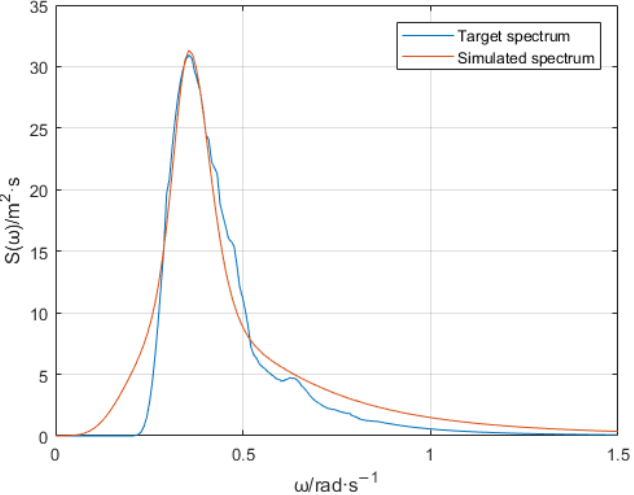
Figure 6. Comparison of simulated wave spectrum and target “ New Year Wave ” spectrum.